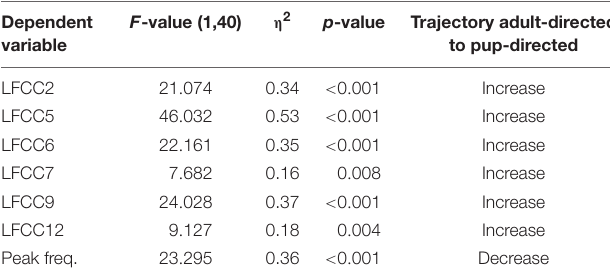
TABLE 1 | Difference in acoustic parameters between pup-directed and adult-directed vocalizations of females.